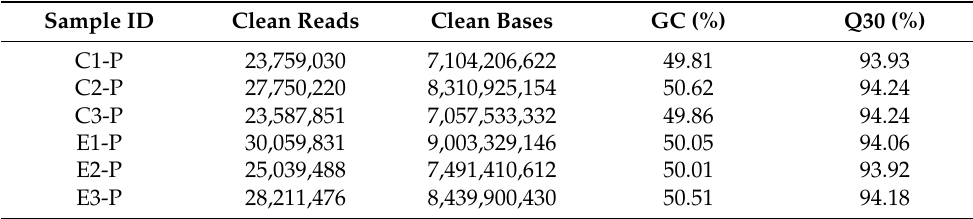
Table 3. Results of transcriptomic sequencing.